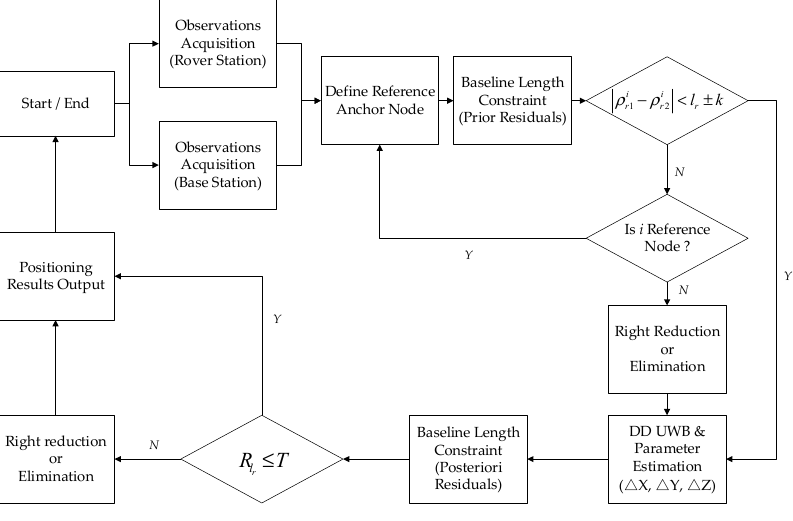
Figure 3. Schematic diagram of the proposed method BC-DUWB.